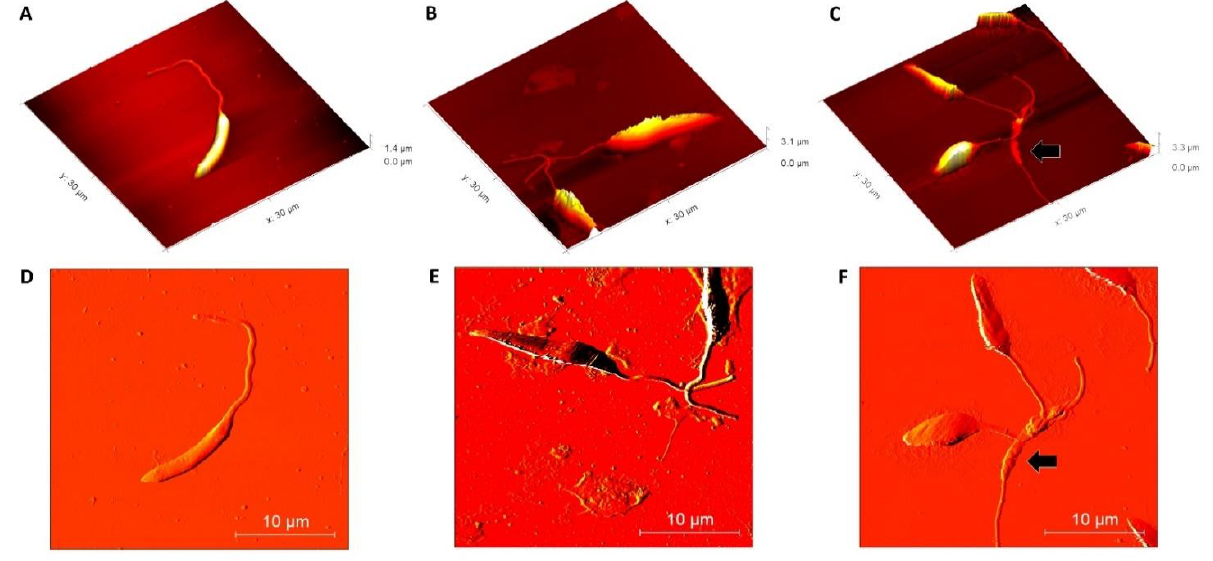
Figure 2. Morphological analysis of Leishmania amazonensis using atomic force microscopy (above: 2D amplitude images; below: 3D height images). ( A , D ): control (untreated); ( B , E ): β -ocimene treated (IC 50 ); ( C , F ) : treated with β -ocimene (2 × IC 50 ). Black arrow: ultrastructural alteration.